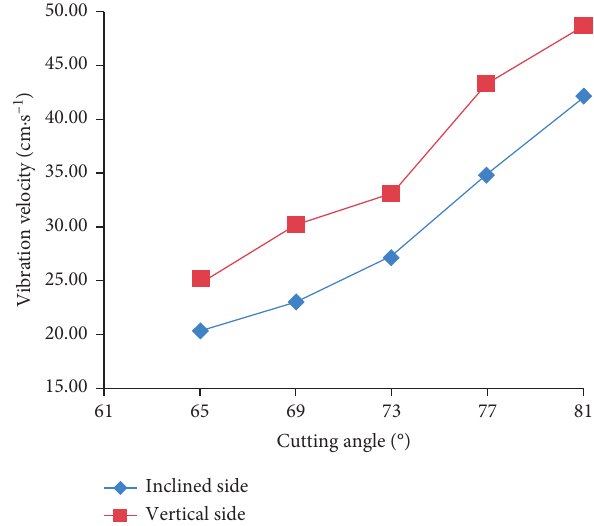
Figure 25: The curve of the inclined and vertical side average resultant velocity with the change of cutting